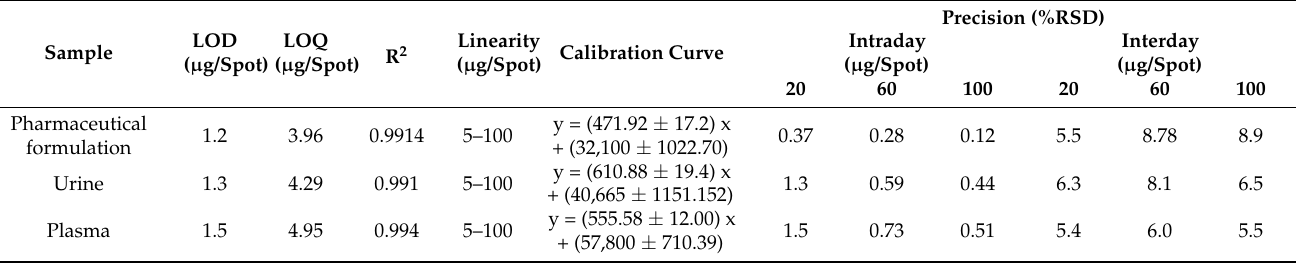
Table 1. Analytical characteristics of the SA-DLLME TLC DIC method for FAV ( n =